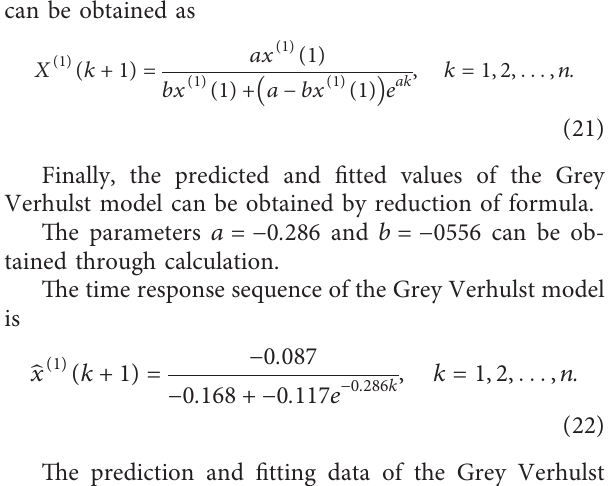
Figure 2: Comparison of Grey Verhulst model forecast data and actual